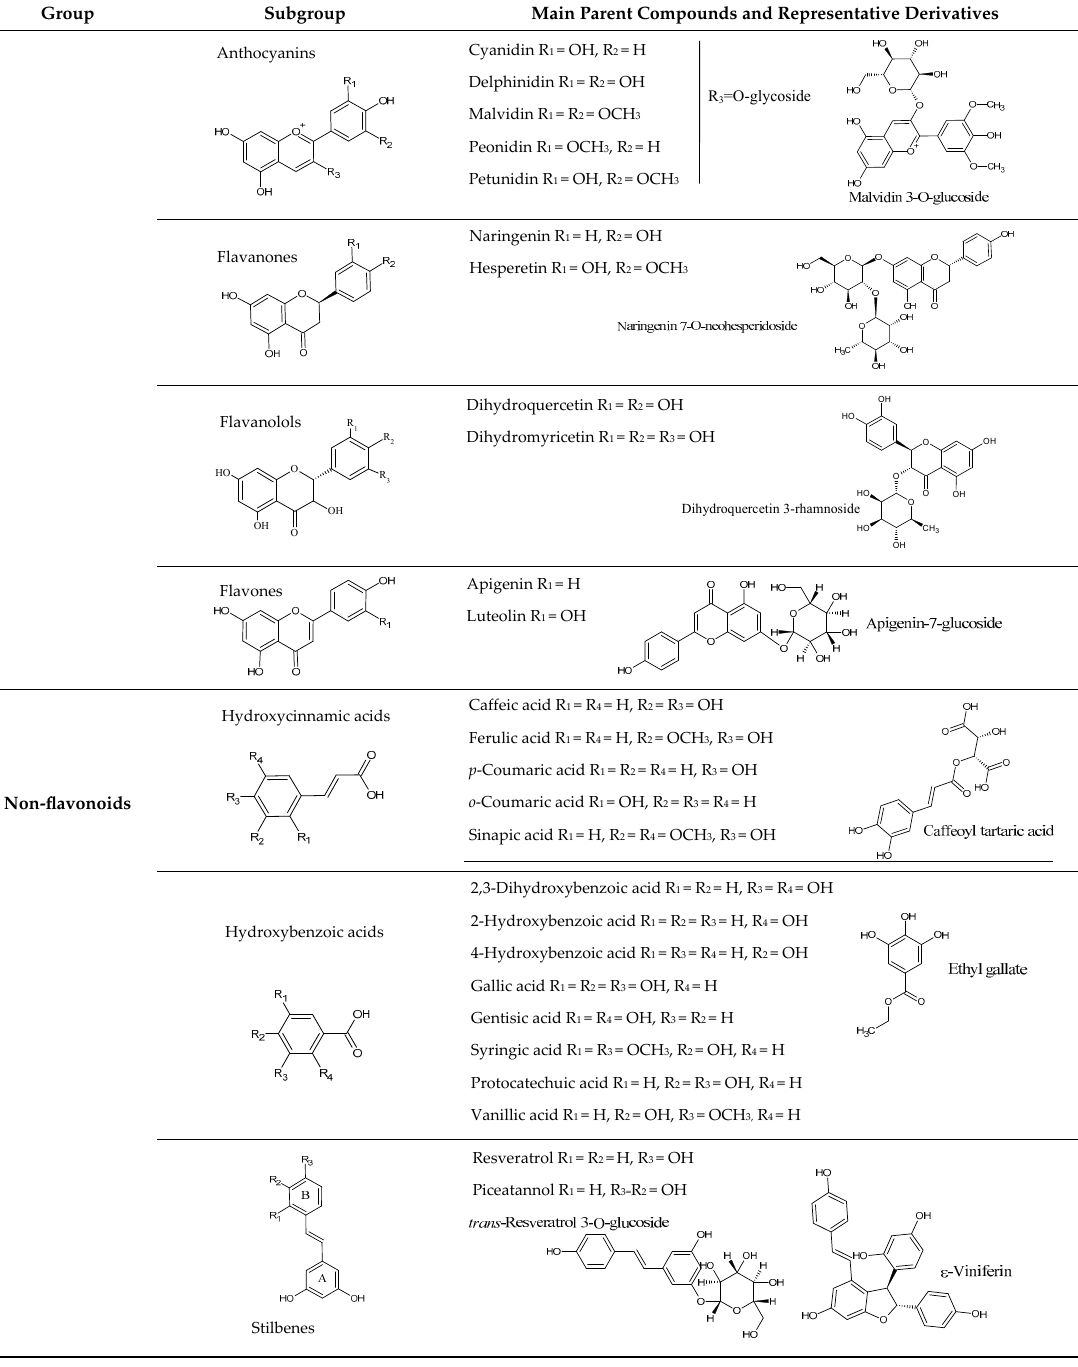
Table 2. Range of total phenolic content in red and white wines in a representative set of studies.